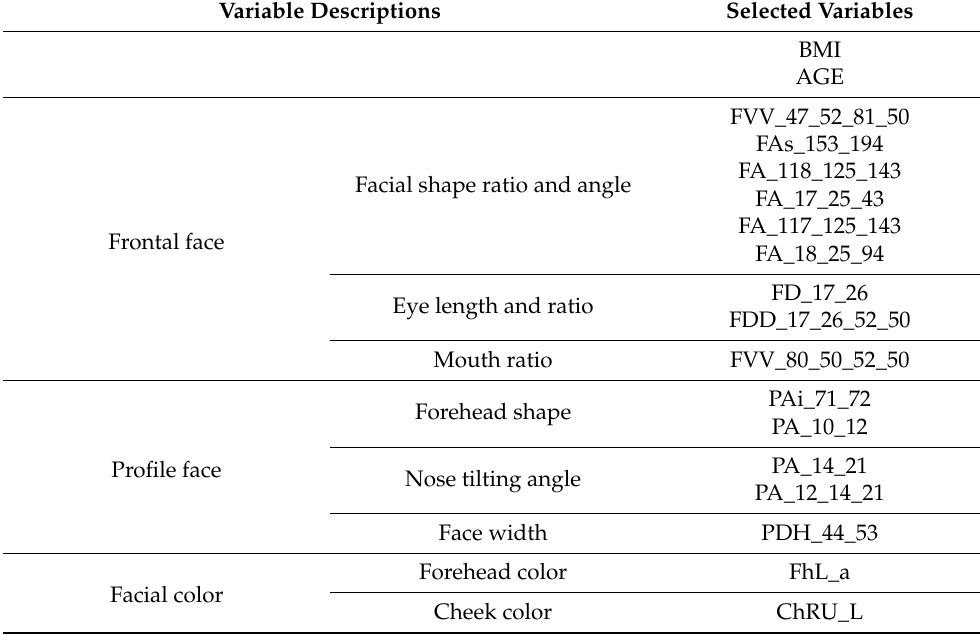
Table 7. Variables selected using a model based on LASSO in